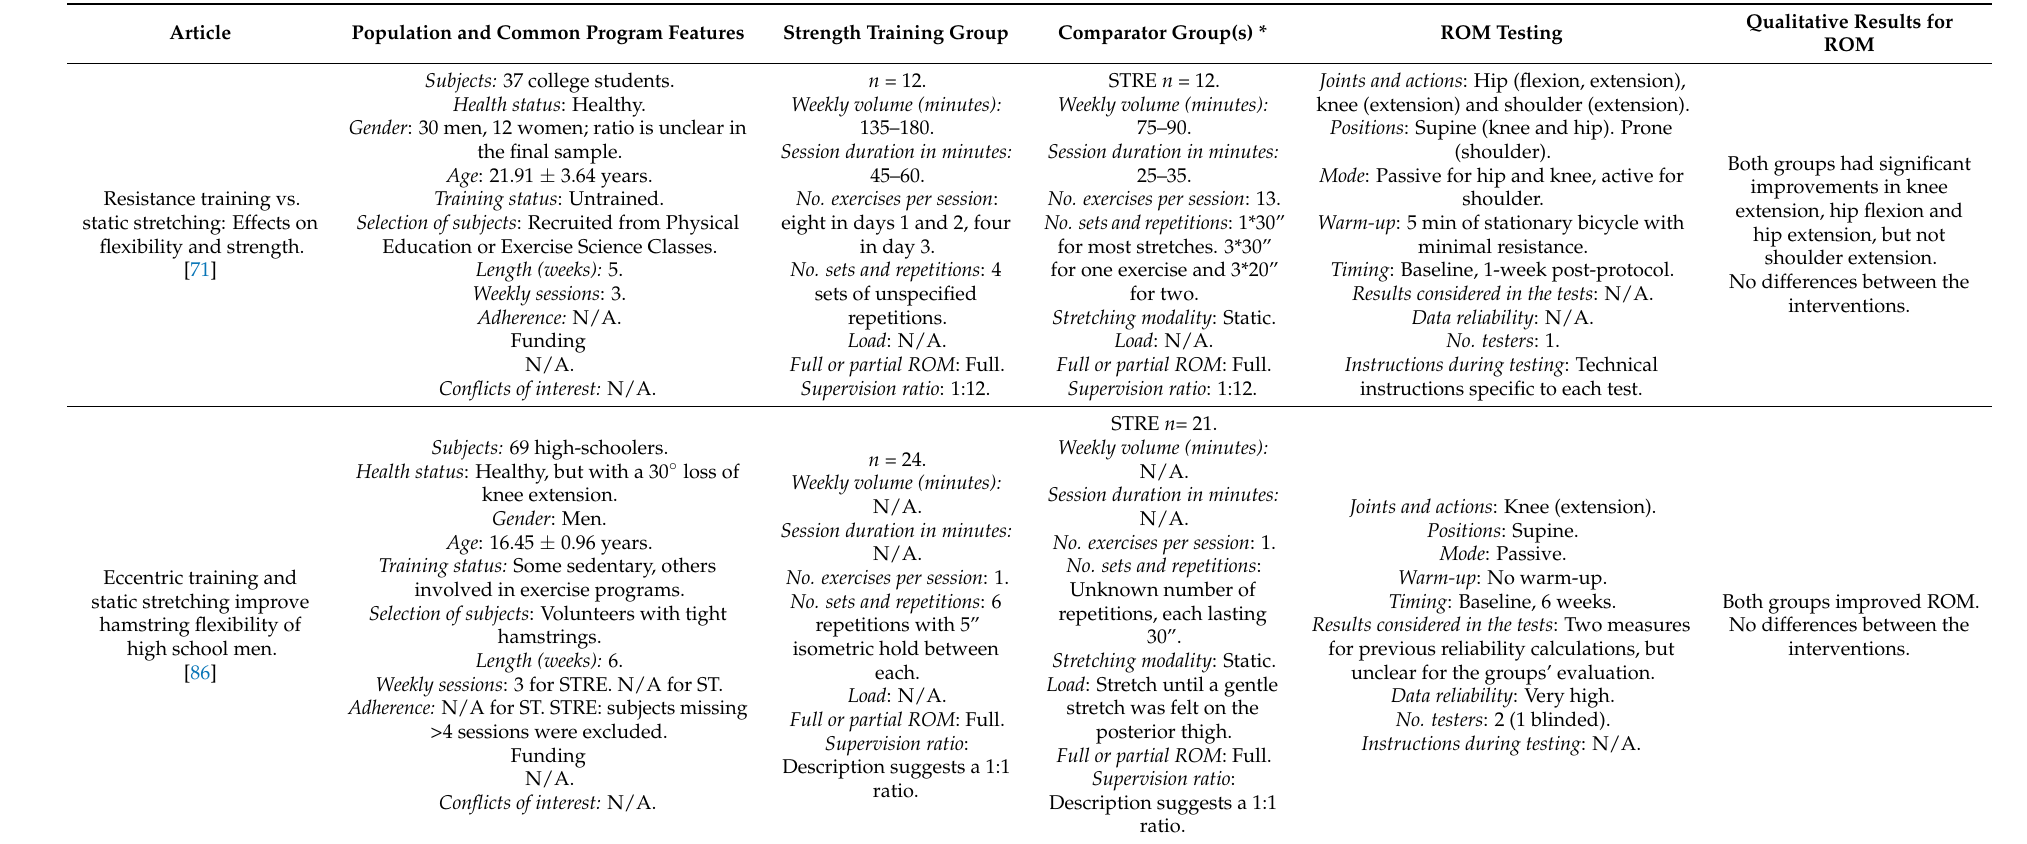
Strength Training Group Comparator Group(s) * ROM Testing